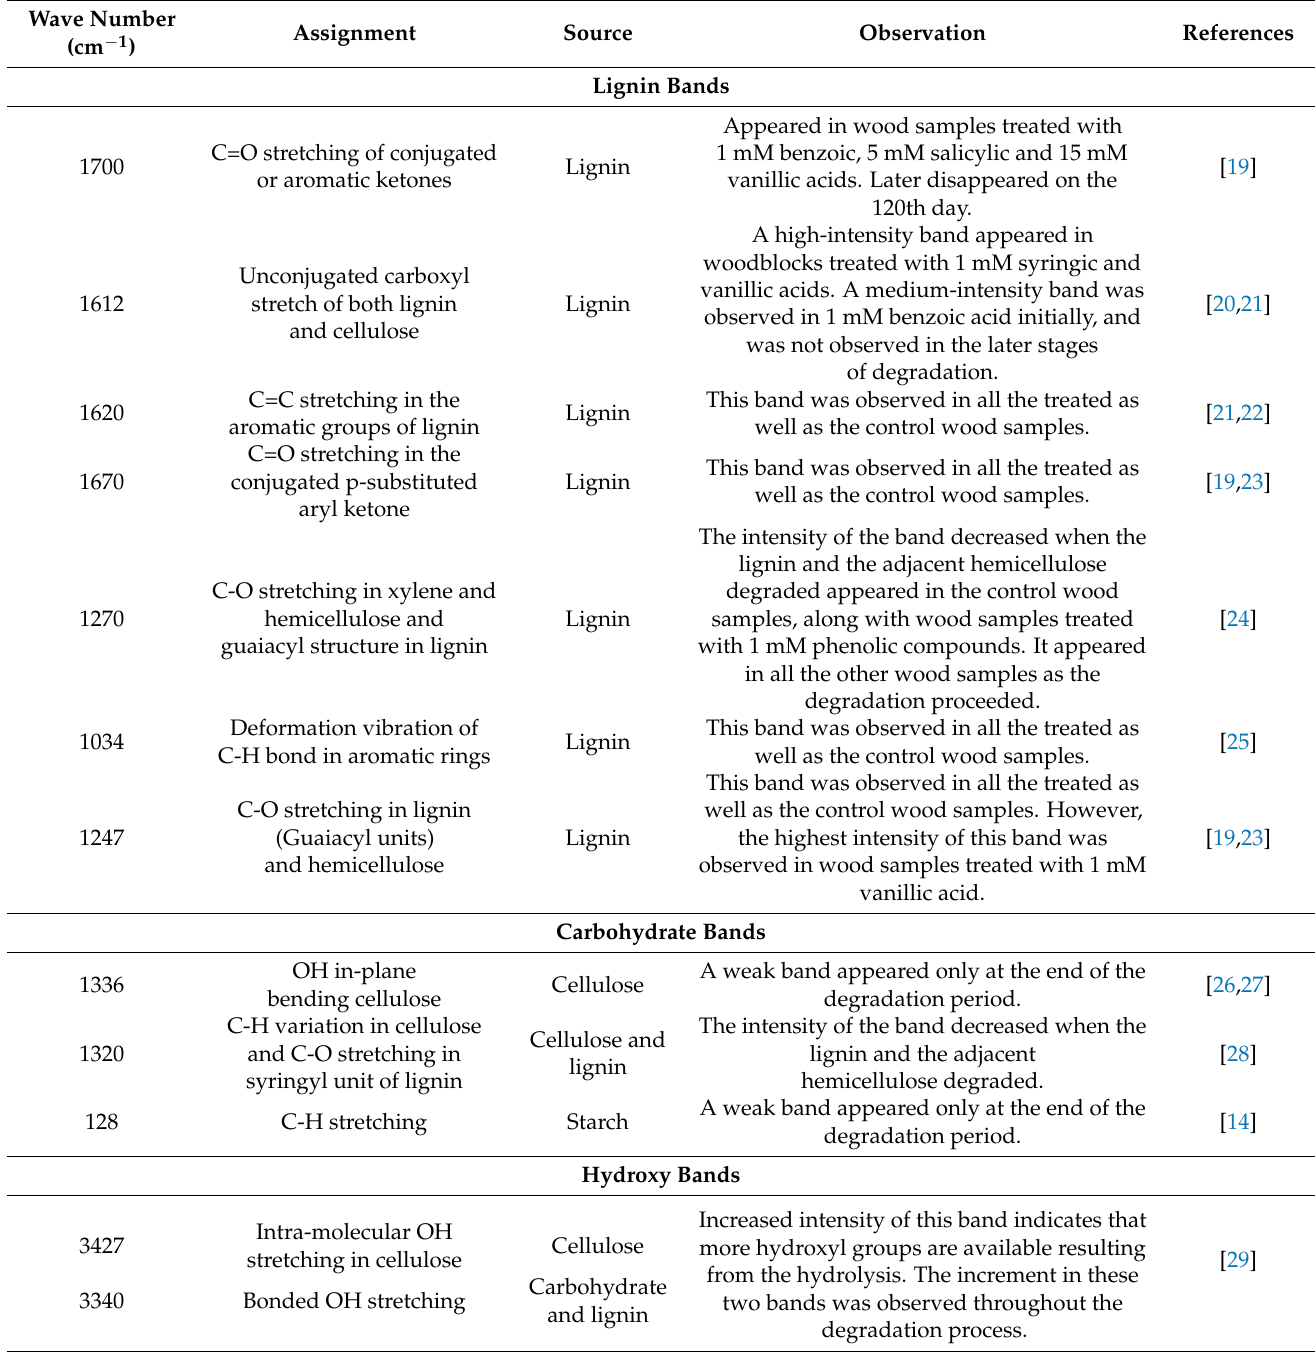
Table 1. Characteristic bands in the FT-IR spectra of the studied oil palm wood samples in the 400–4000 cm − 1 region. Wave Number (cm − 1